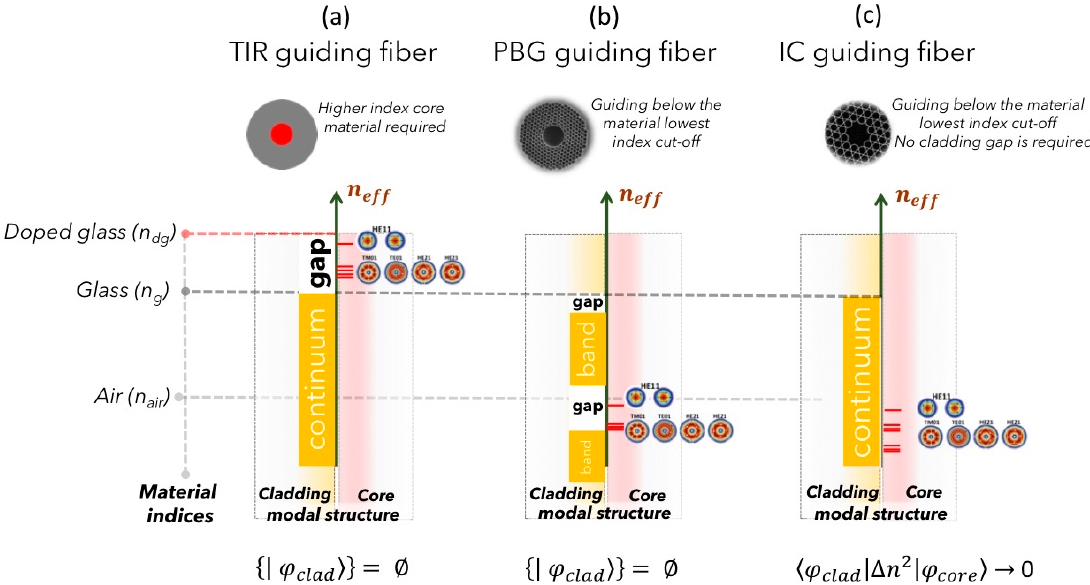
Figure 4. Modal content representation of the three different optical guiding fibers: ( a ) Total Internal Reflection (TIR); ( b ) Photonic Band Gap (PBG); and ( c ) Inhibited Coupling (IC) guiding fibers.